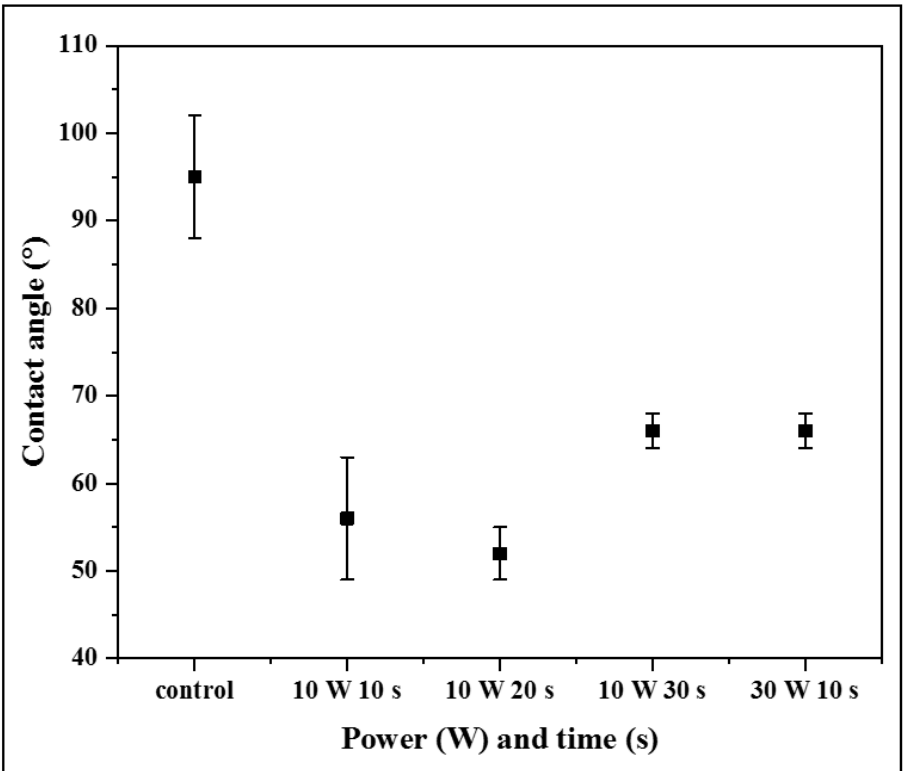
Figure 4. Water contact angle measurements of H 2 O-LPP-treated and untreated Bambara groundnut seeds. Experiments were performed in five replicates, n = 5, with five seeds per replicate. Error bar refers to standard deviations for the five replicates. All plasma-treated groups are significantly different from the control group ( p < 0.05).